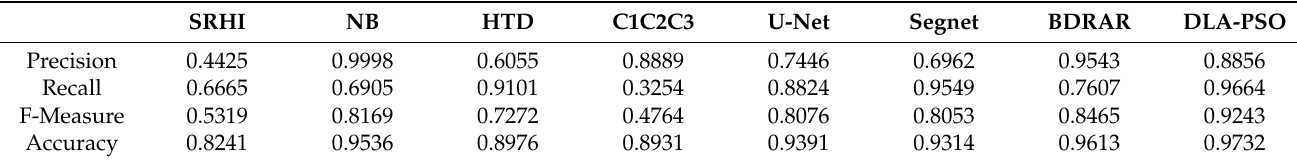
Table 8. Evaluation index for vegetation shadow in Kitsap district.